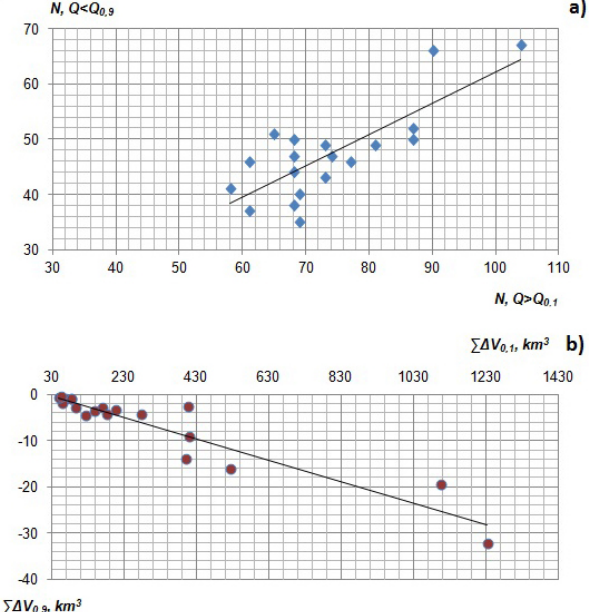
Figure 4. Relationship between the number of periods of extremely low and extremely high flow (a) and total volume deficit and sur- plus (b) .